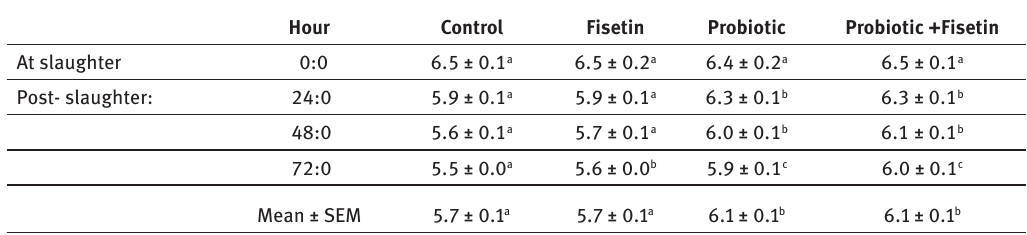
Table 6 Changes in pH of the breast muscle in broiler chickens administered with probiotic and/or fisetin